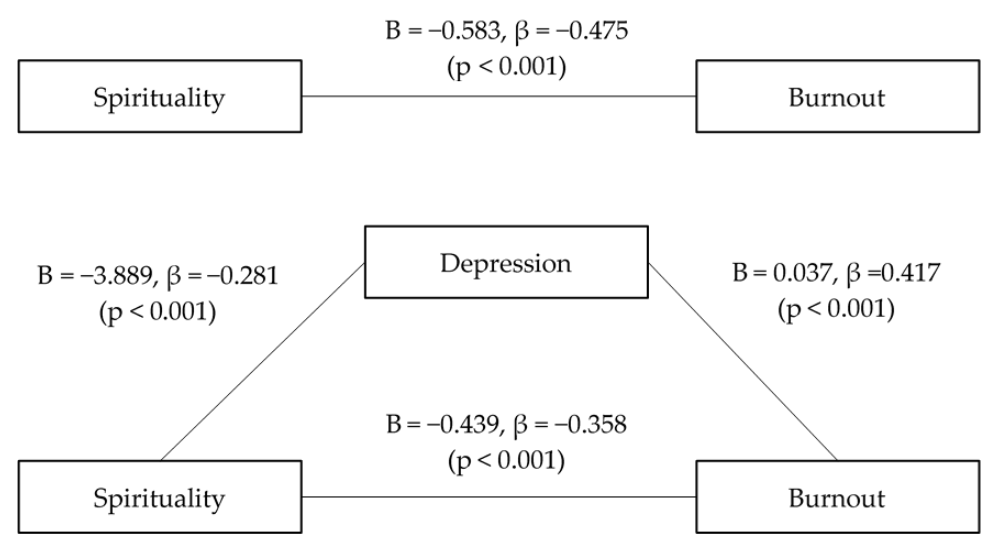
Figure 2. Mediation model of the effects of depression on the relationship between spirituality and burnout (Sobel’s test: Z = −3.092, p =0.001) .